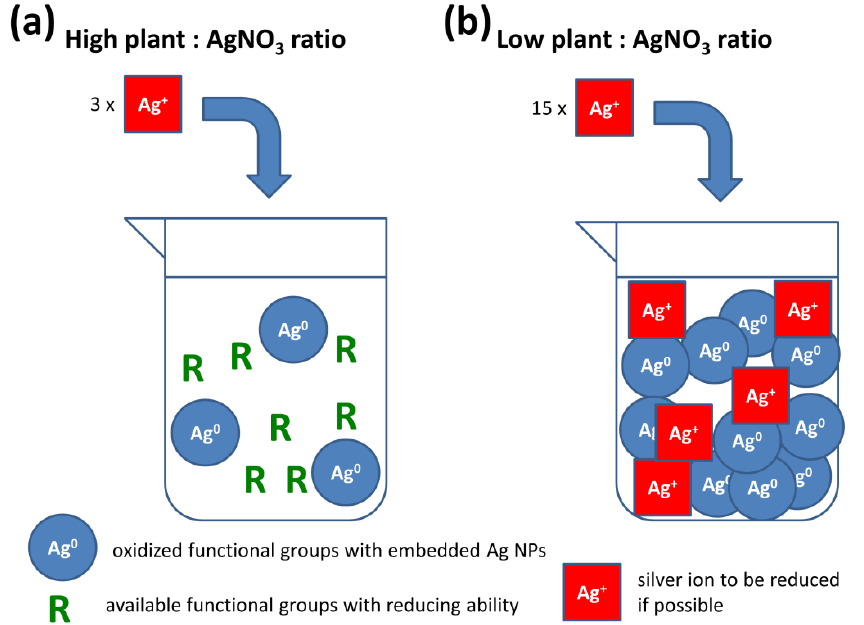
Figure 8. Schematic illustration of the events taking place in the flask during the green synthesis of nanoparticles at ( a ) high and ( b ) low plant:AgNO 3 ratios. nanoparticles at ( a ) high and ( b ) low plant:AgNO 3